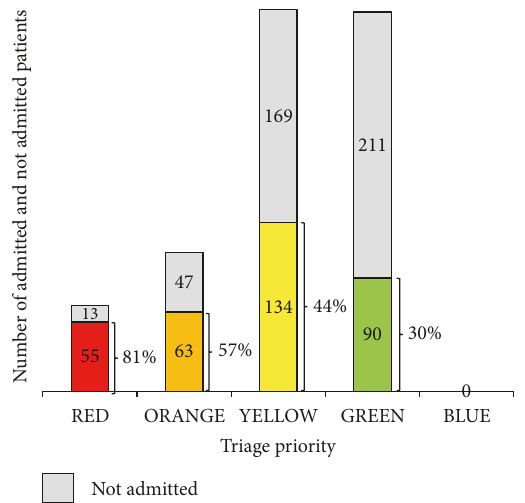
Figure 1: Number (N) of admitted and not admitted patients by the triage priority red, orange, yellow, green, and blue.